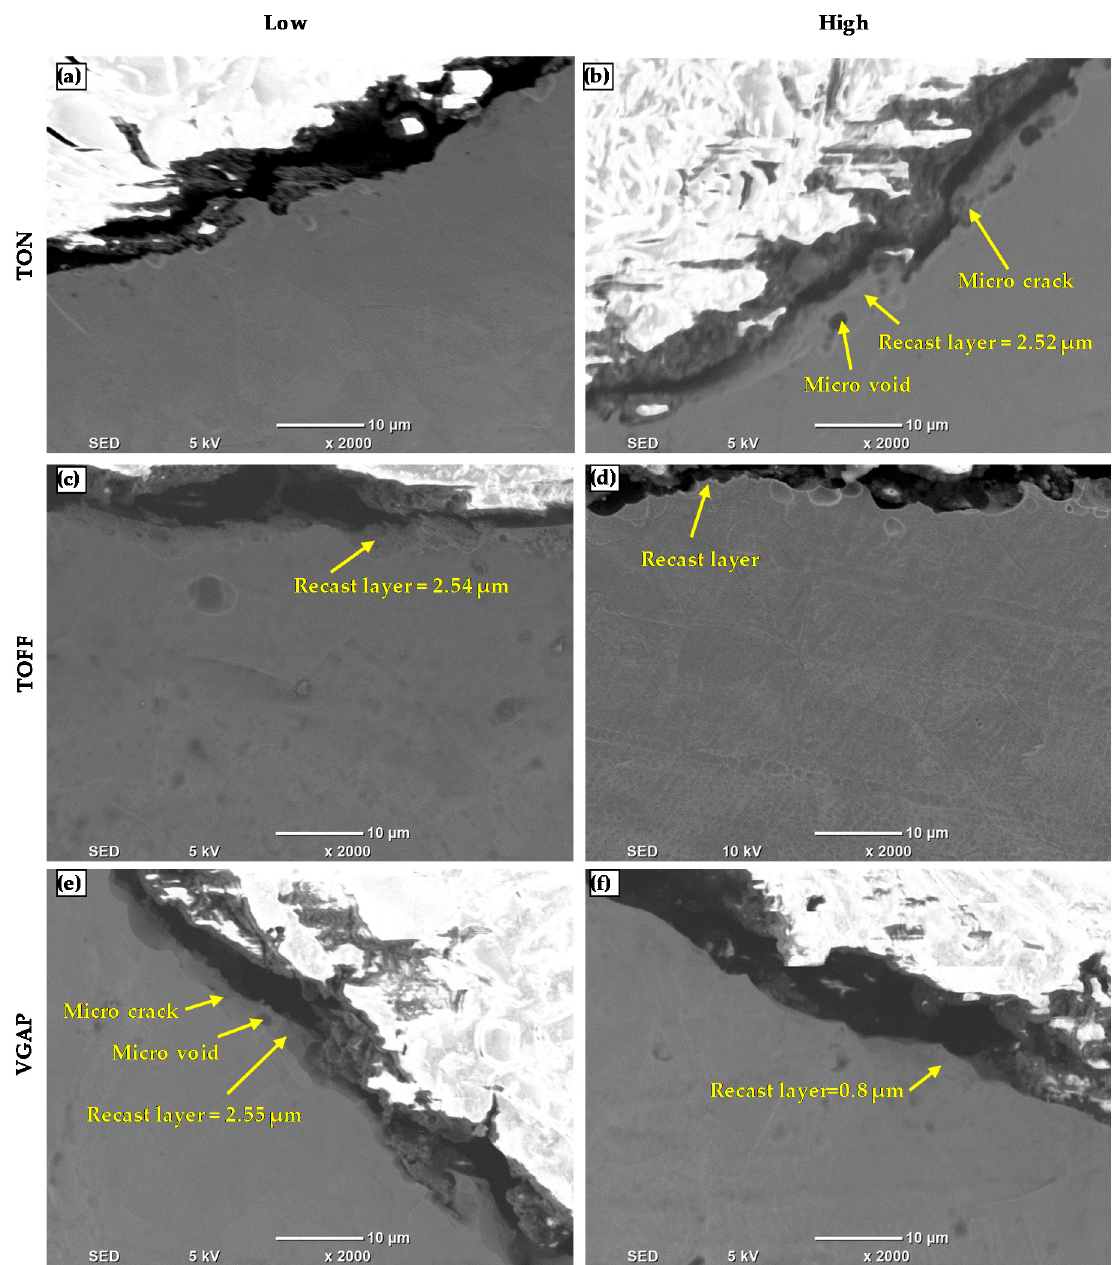
Figure 14. Microstructure of WEDM machined surfaces at ( a ) low TON (1 MU) ( b ) high TON (9 MU) ( c ) low TOFF (1 MU) and ( d ) high TOFF (9 MU) ( e ) low VGAP (35 V) and ( f ) high VGAP (75 V).